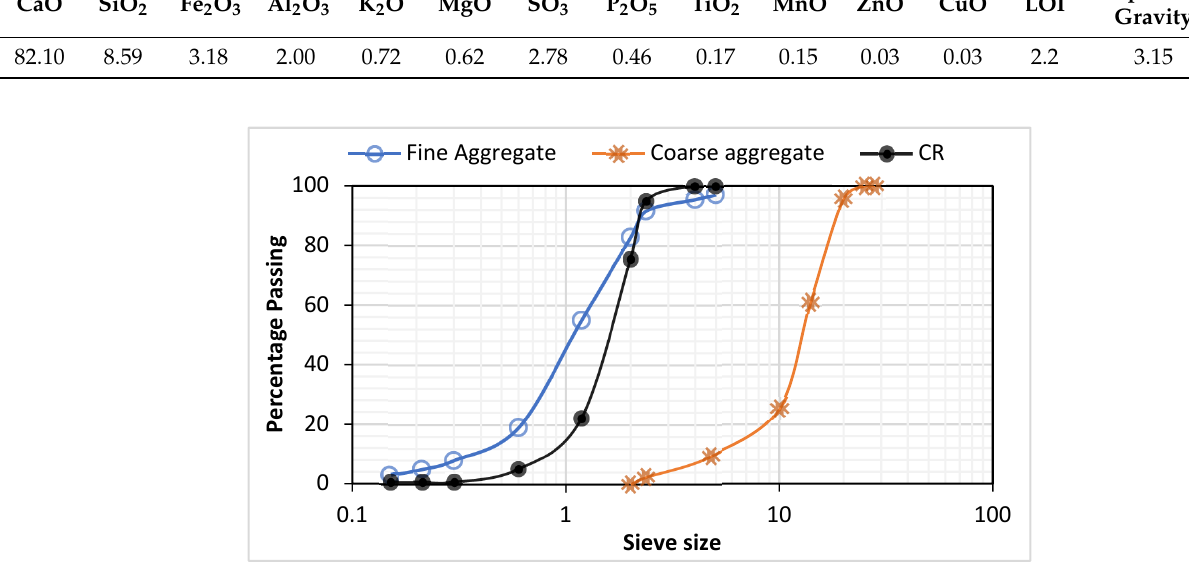
Figure 1. Grading curves for the aggregates and crumb rubber (CR).